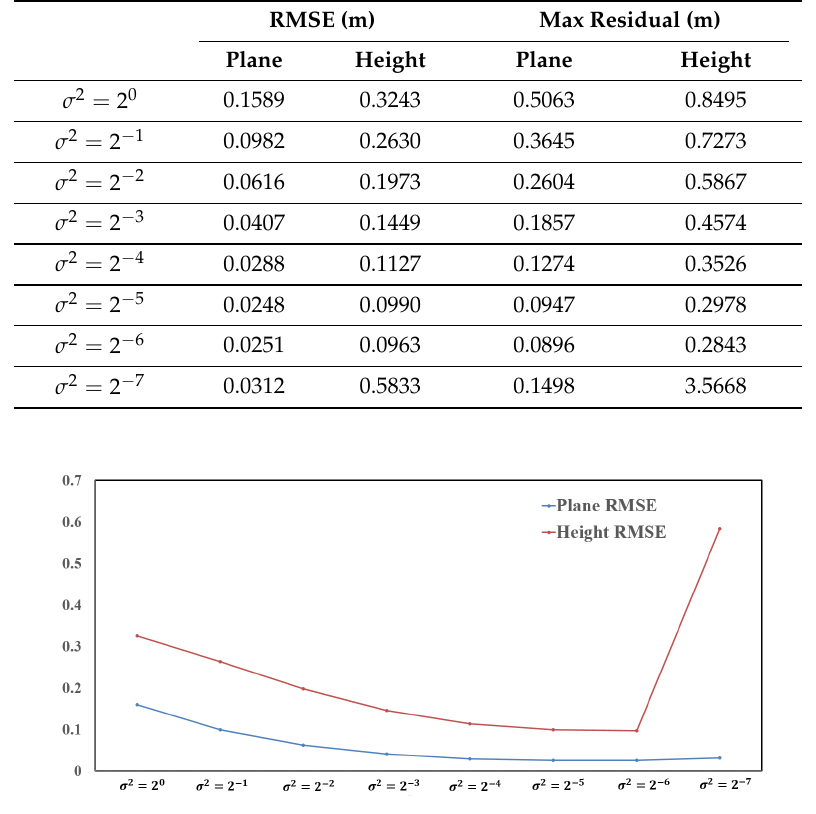
Table 7. The RMSE and maximum residual of the plane and height directions obtained using different parameters in the Gaussian kernel function.